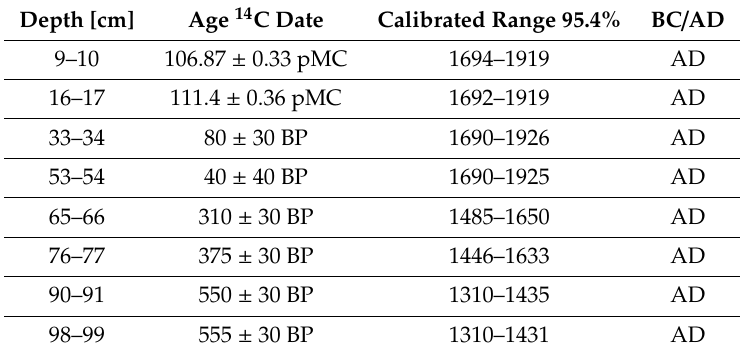
Table 3. The radiocarbon 14 C dates for Baltic-type raised bog